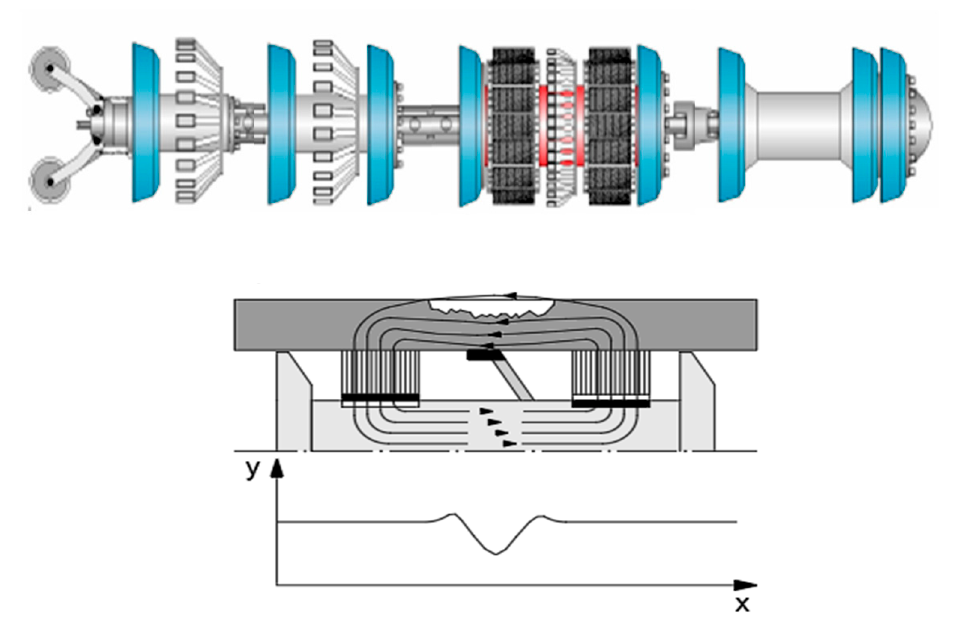
Figure 2. Axial excitation magnetic flux leakage inspection technology: a diagnostics tool (at the top) and a measurement principle (at the bottom). Author’s source.